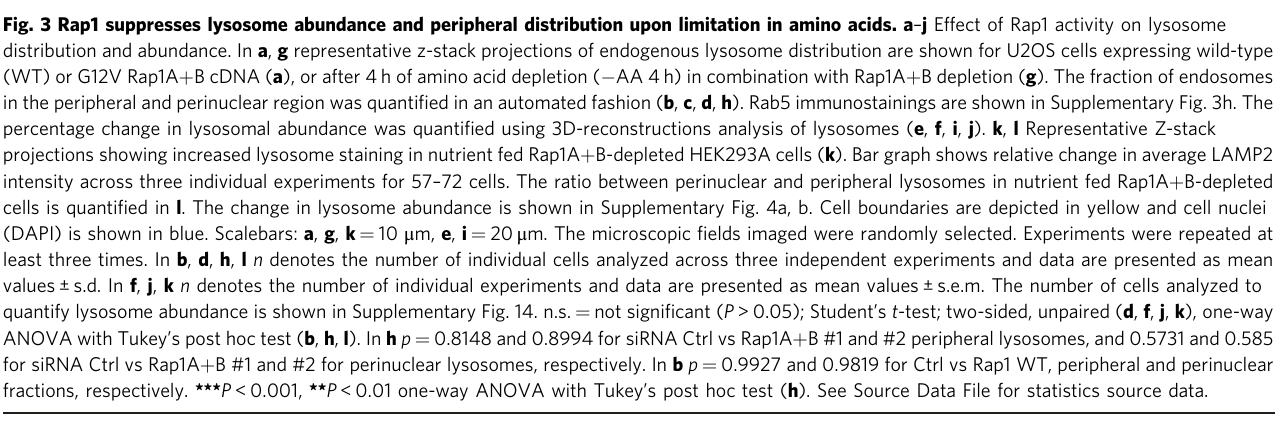
Fig. 3 Rap1 suppresses lysosome abundance and peripheral distribution upon limitation in amino acids. a – j Effect of Rap1 activity on lysosome distribution and abundance. In a , g representative z-stack projections of endogenous lysosome distribution are shown for U2OS cells expressing